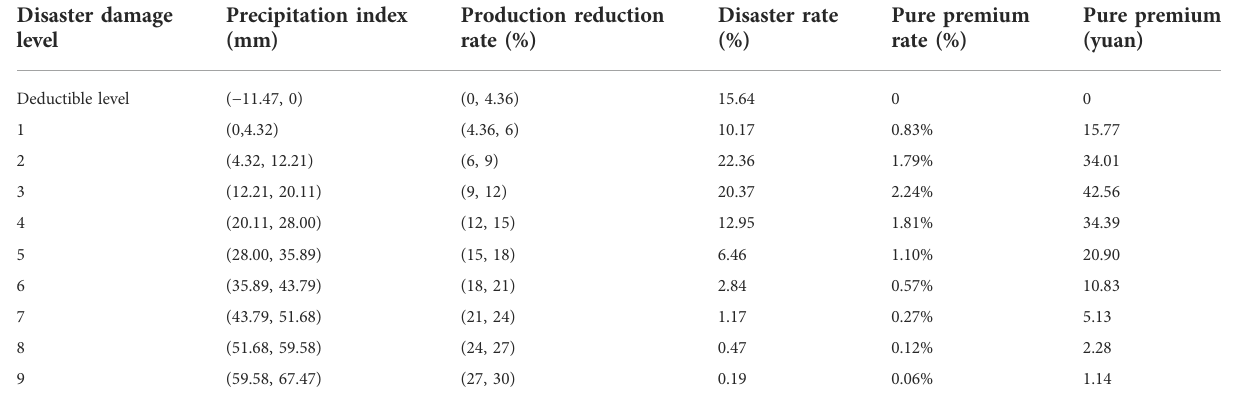
TABLE 6 Net premium rates under different disaster